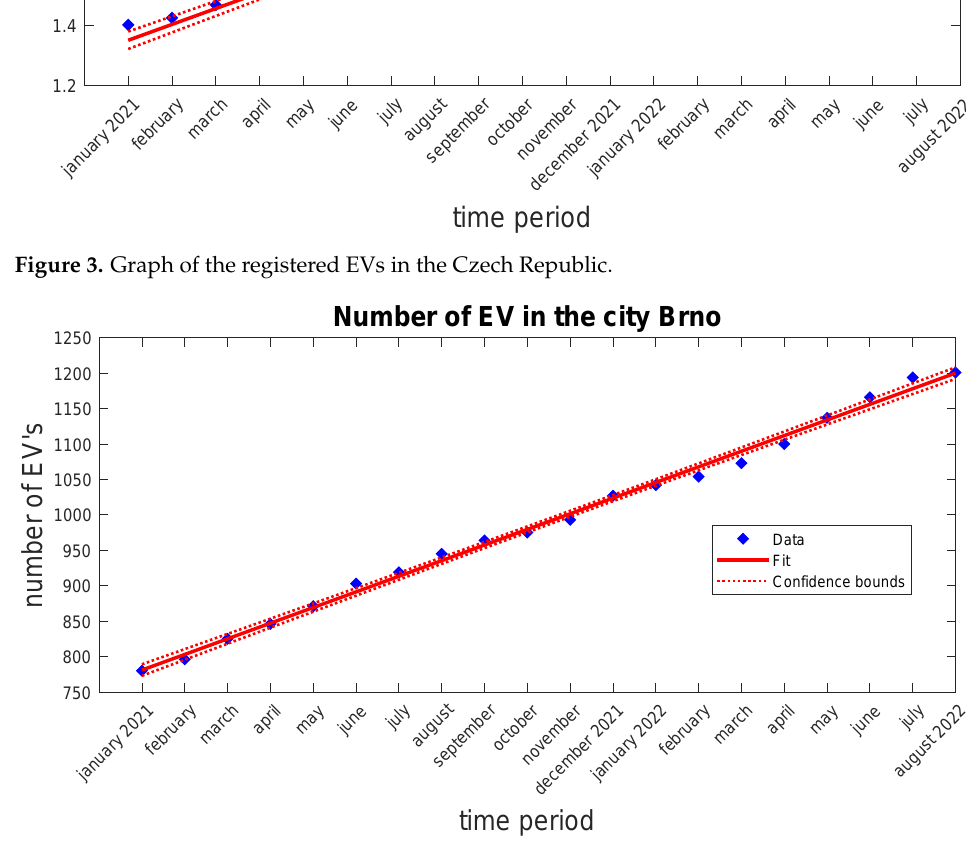
Figure 4. Graph of the registered EVs in